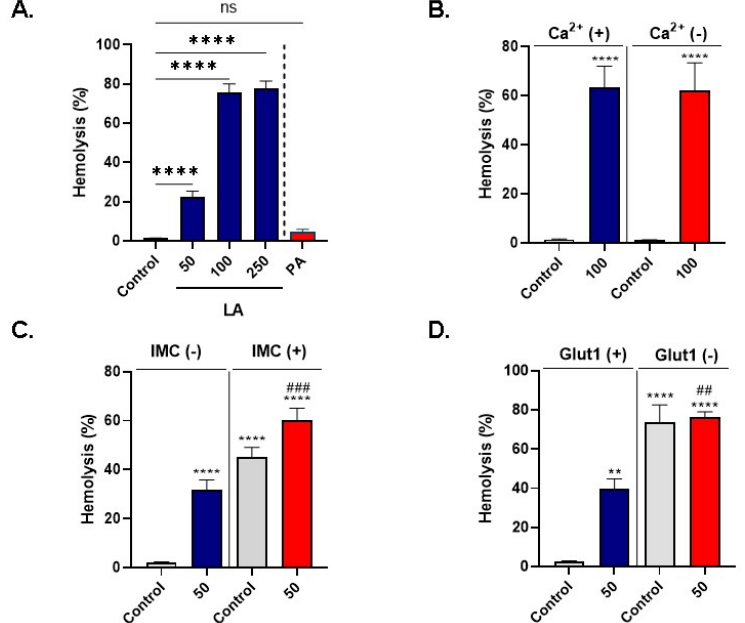
Figure 1. LA stimulates Ca 2+ -independent hemolysis. ( A ) LA but not PA induces dose-dependent hemolysis. ( B ) Ca 2+ sensitivity of LA-induced hemolysis. ( C ) Ionophoric challenge with IMC does not aggravate LA-induced hemolysis. ( D ) Inhibition of glucose uptake by Glut1 inhibitor WZB117 does not exasperate LA-induced hemolysis. ns indicates not significant, ** ( p < 0.01) and **** ( p < 0.0001) indicate significantly different values from control conditions whereas ## ( p < 0.01) and ### ( p < 0.001) indicate statistical significance compared to LA-treated cells.